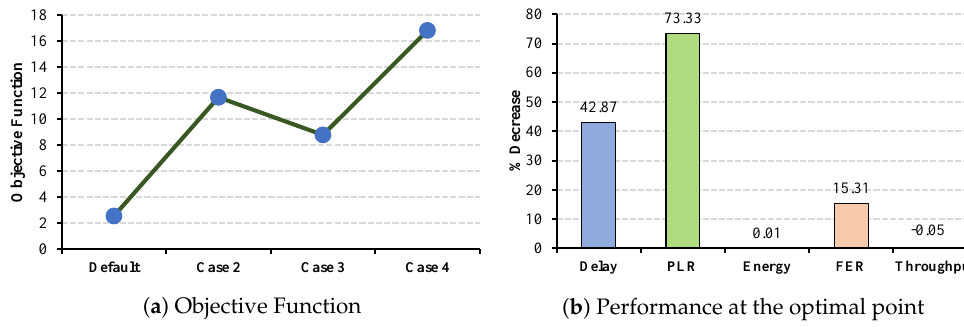
( b ) Performance at the optimal point Figure 15. EEG QoS metrics and energy consumption under CW changes for slave cells.